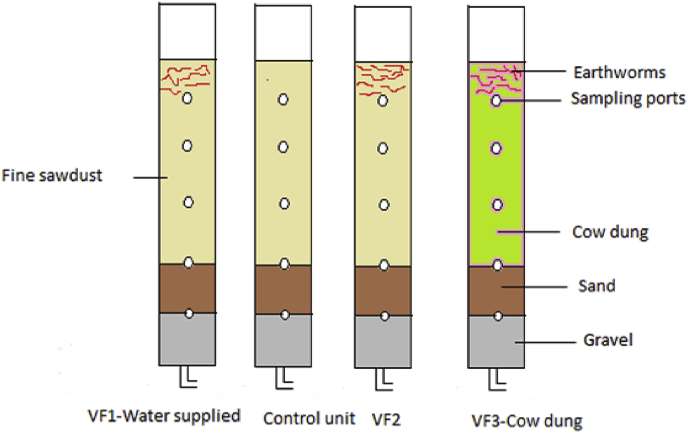
Experimental set up.